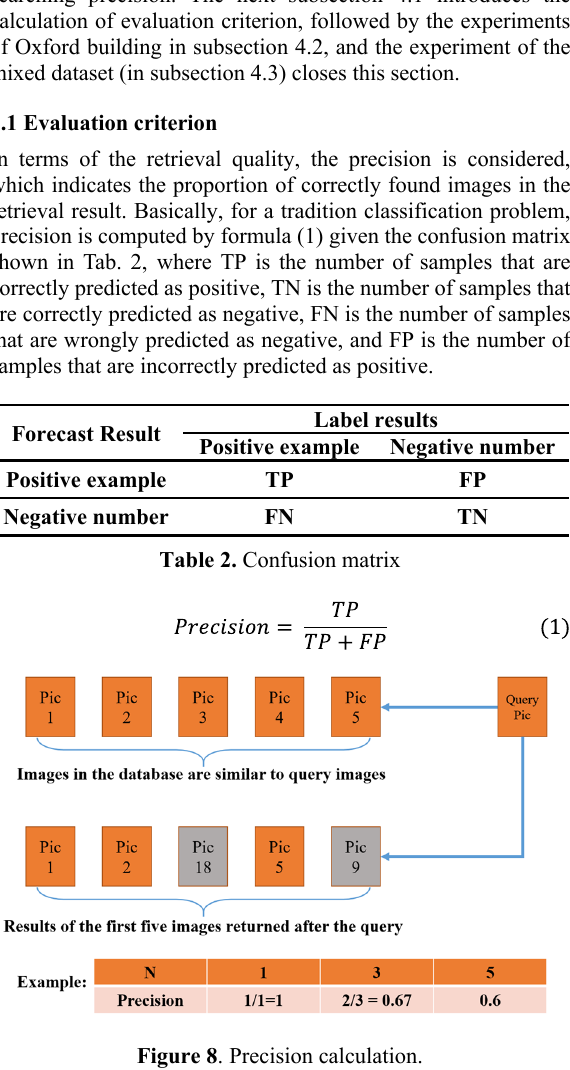
Figure 8 . Precision